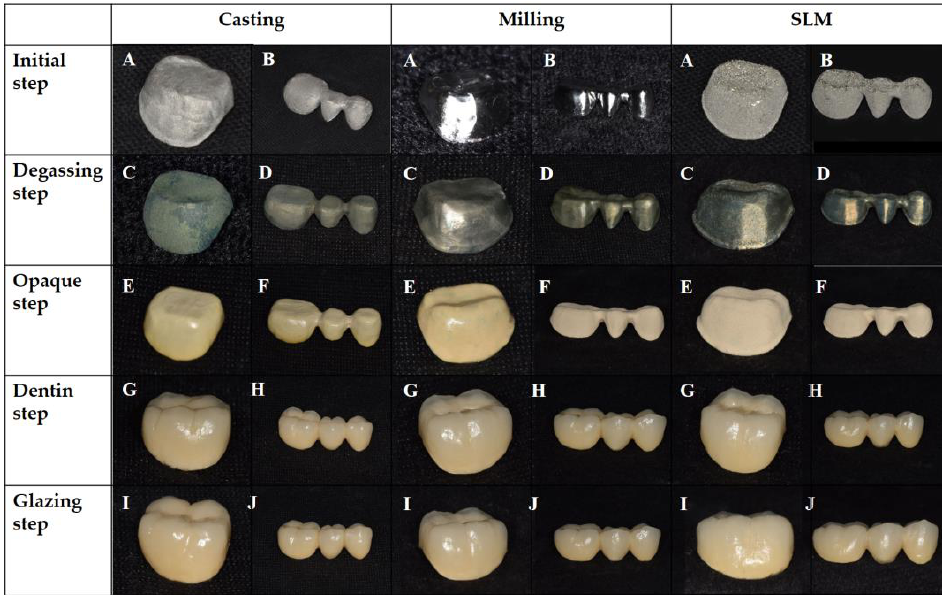
Figure 8. PFM dental restoration using casting, milling, and SLM methods. ( A ): single metal coping, ( B ): 3-unit bridge metal coping, ( C ): single coping after oxidizing process, ( D ): 3-unit bridge coping after the oxidizing process. ( E ): single coping after opaque porcelain firing procedure, ( F ): 3-unit bridge coping after opaque porcelain firing procedure, ( G ): single coping after dentin porcelain firing procedure, ( H ): 3-unit bridge coping after dentin porcelain firing procedure, ( I ): single coping after glazing procedure, ( J ): 3-unit bridge coping after glazing procedure.